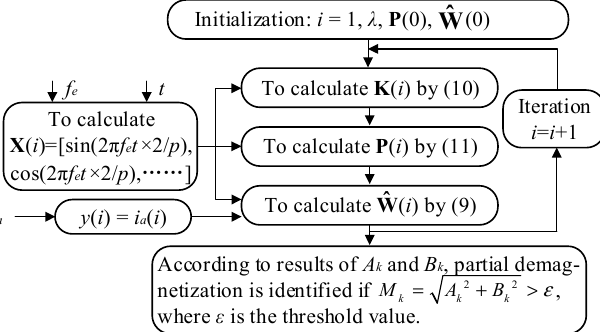
Figure 3. Flowchart of proposed methodology.